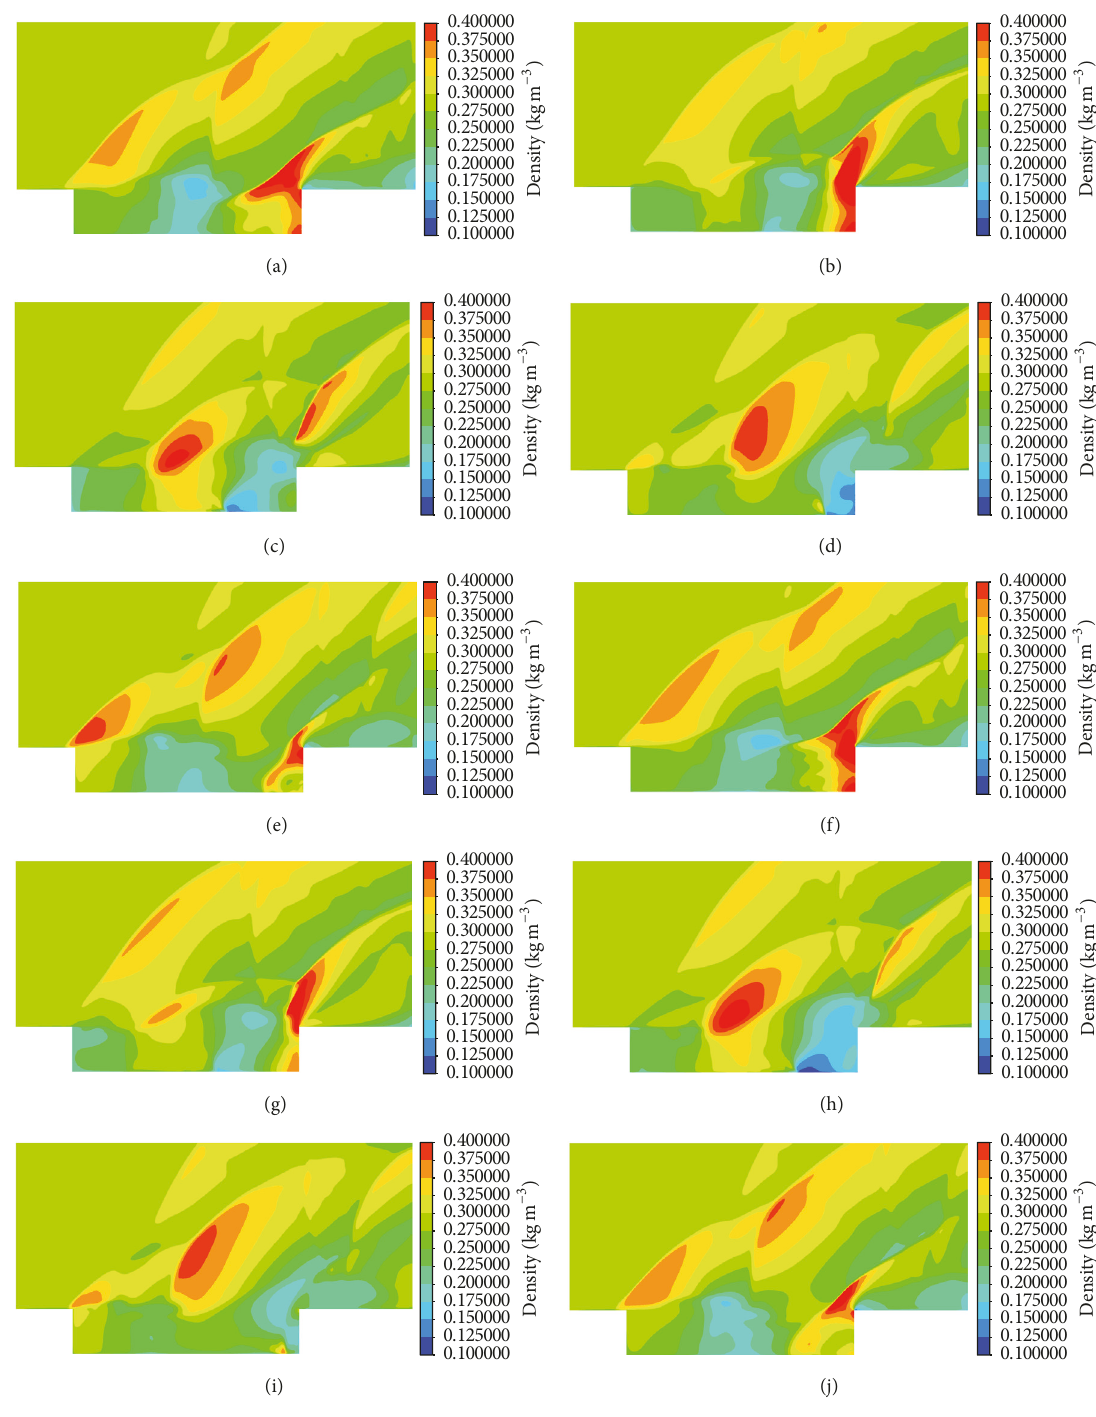
Figure 6: Density contours for the baseline case (a) 𝑡/𝑡 𝑅 = 0 , (b) 𝑡/𝑡 𝑅 = 0.11 , (c) 𝑡/𝑡 𝑅 = 0.22 , (d) 𝑡/𝑡 𝑅 = 0.33 , (e) 𝑡/𝑡 𝑅 = 0.44 , (f) 𝑡/𝑡 𝑅 = 0.55 , (g) 𝑡/𝑡 𝑅 = 0.66 , (h) 𝑡/𝑡 𝑅 = 0.77 , (i) 𝑡/𝑡 𝑅 = 0.88 , and (j) 𝑡/𝑡 𝑅 = 1 .